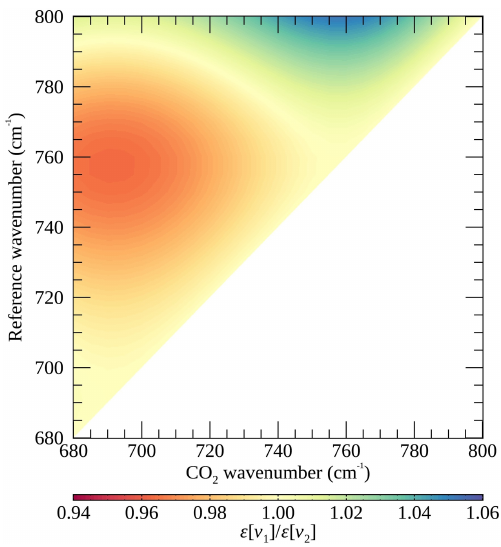
Figure 5. Emissivity ratio for channels between 680 and 800cm − 1 . The ash sample was from the Eyjafjallajökull eruption in 2010. The assumption that the emissivity does not vary significantly for the pair of channels used for the CO 2 slicing is important. For this to hold true, ideally the emissivity ratio should be close to